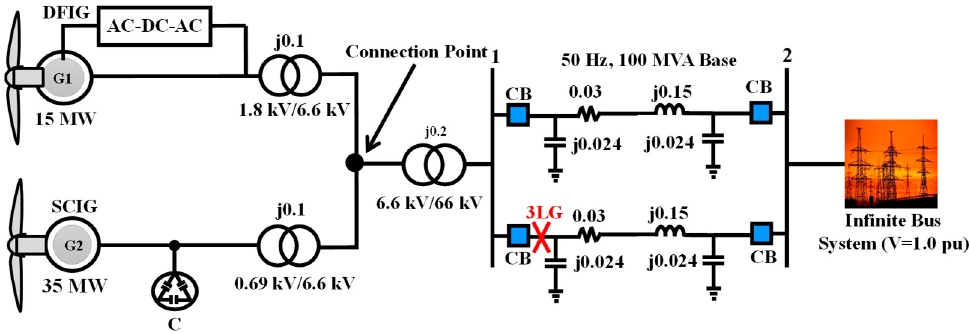
Figure 1. Power system